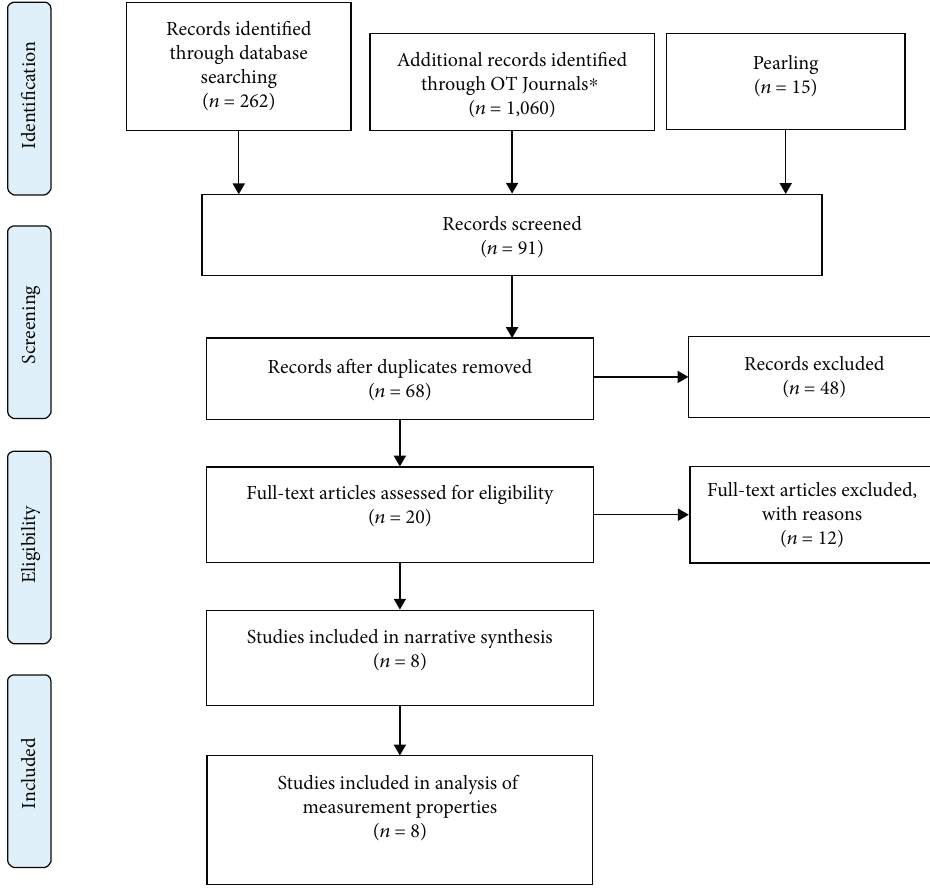
Figure 1: PRISMA fl ow